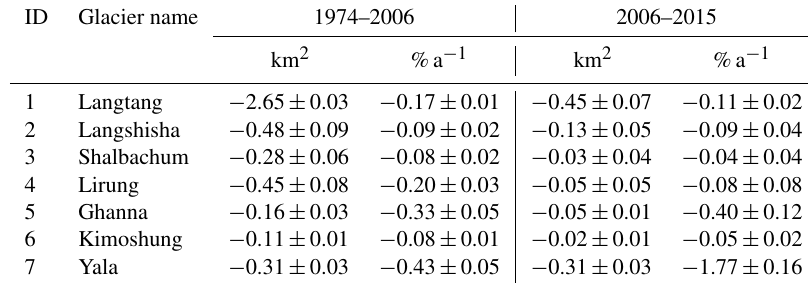
Table 7. Characteristics of the debris-covered tongues (debris-covered glacier area excluding tributary branches). Cliff area